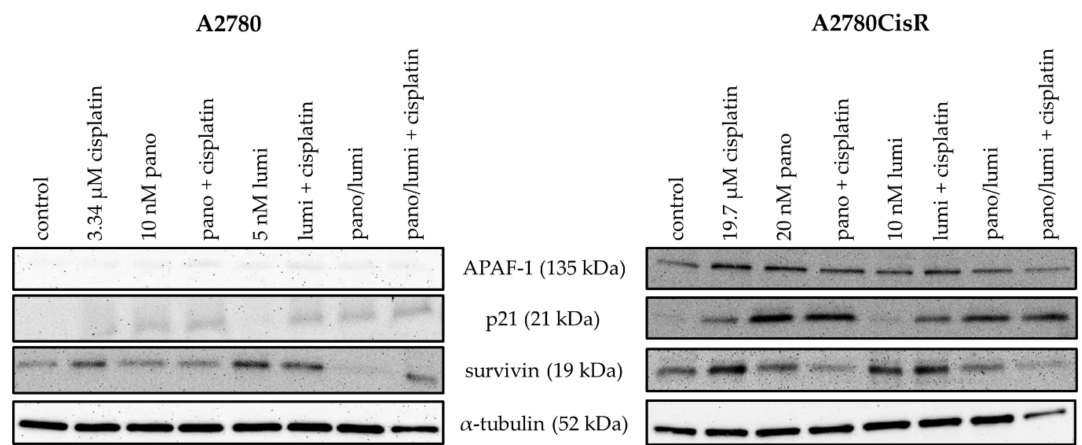
Figure 6. E ff ects of HDACi and HSP90i incubation or preincubation prior to cisplatin on protein expression levels of pro- / antiapoptotic proteins. Representative immunoblot analysis of APAF-1, p21 , survivin and α -tubulin (as loading control) in A2780 and A2780CisR cells is shown. For combination treatments, panobinostat (pano) and / or luminespib (lumi) were administrated 48 h prior to 24 h cisplatin treatment with respective IC 50 concentrations. Cell line specific control was treated with vehicle for 72 h. Densitometric analysis of the Western blots are shown in Figure S11.